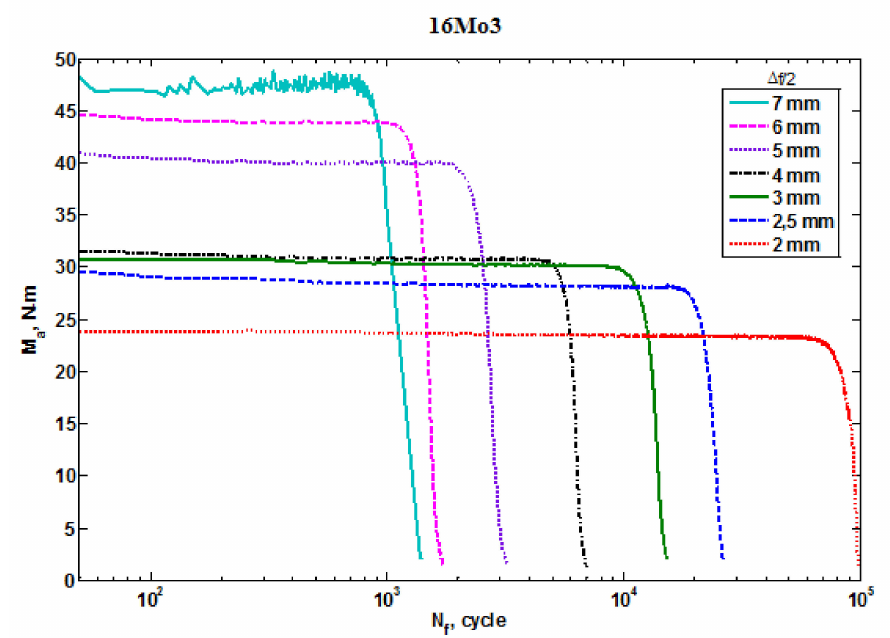
Figure 3. The change in the moments that induce bending, depending on the number of cycles at constant deviation amplitudes.